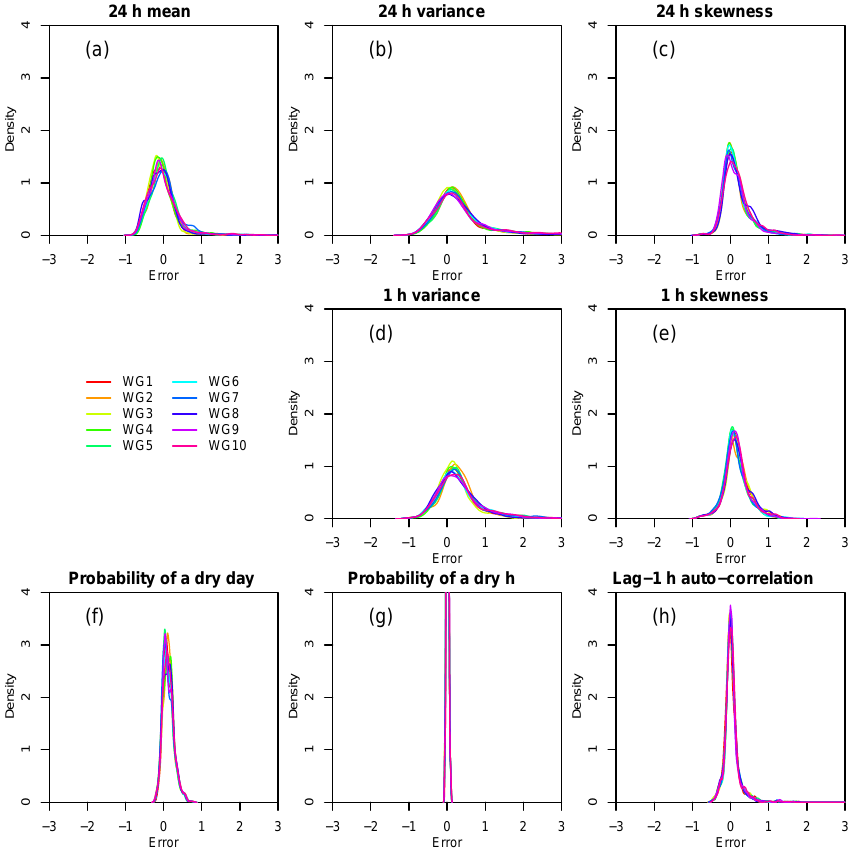
Figure 5. Density plots for the normalized error between the WG and the SVK data sets for each considered statistic ( i = [1 ... 8]) for all months ( j = [1 ... 12]) for all WG realizations ( l =